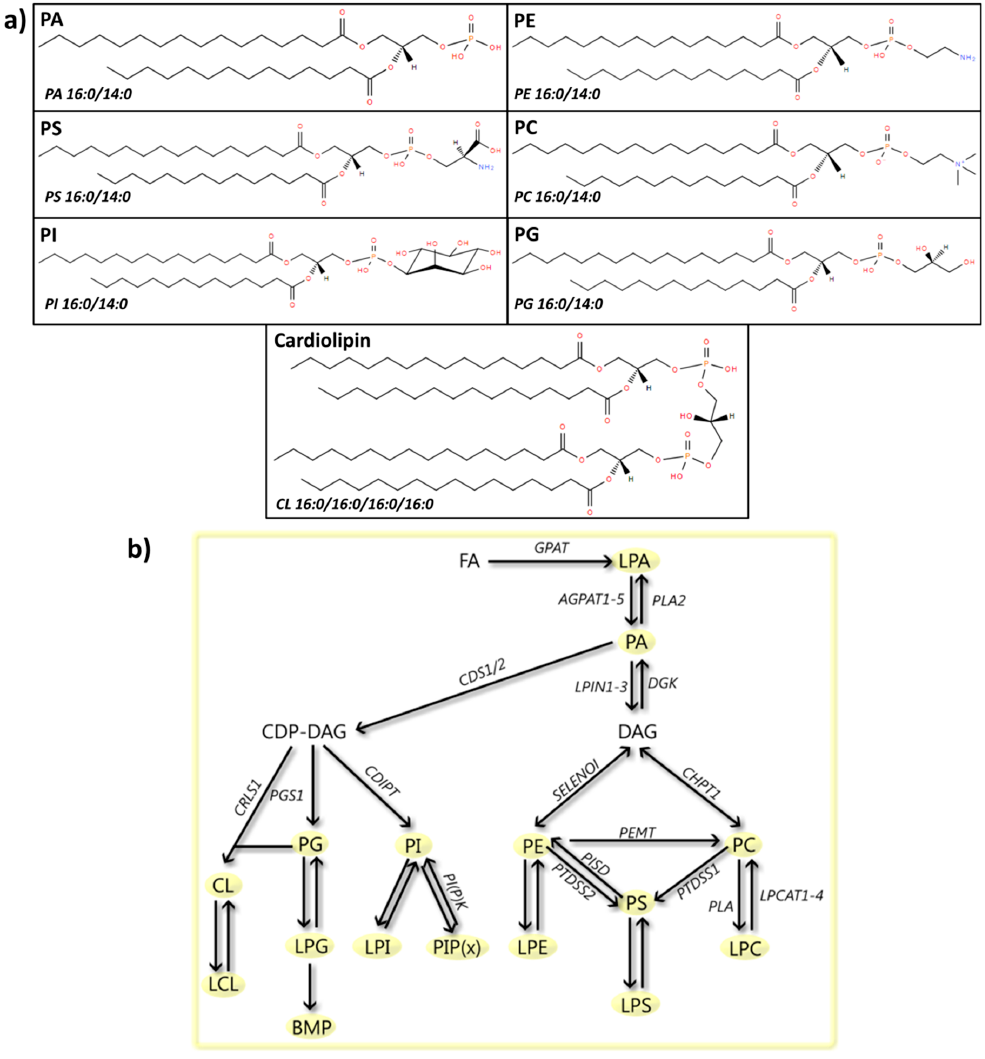
Figure 4. Phospholipids: structures and metabolic steps involved. ( a ) Schematic representation of the chemical structures of